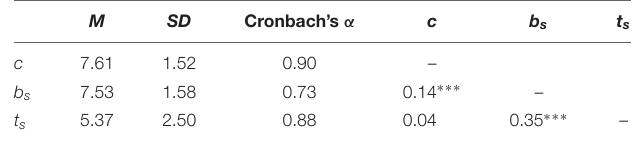
TABLE 2 | Descriptive statistics, internal consistencies, and intercorrelations for the AASQ